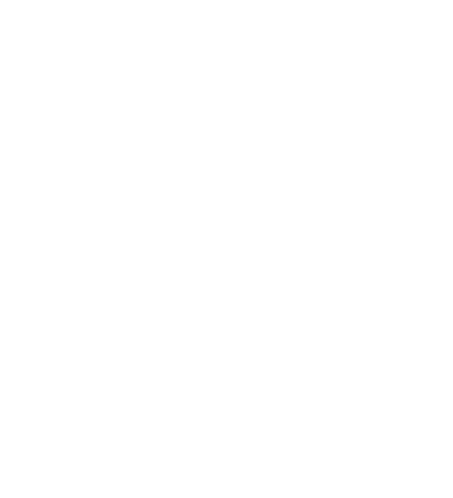
Figure 19. The separating border of the classifier “SVM ω 2 ” in the three-dimensional feature space.